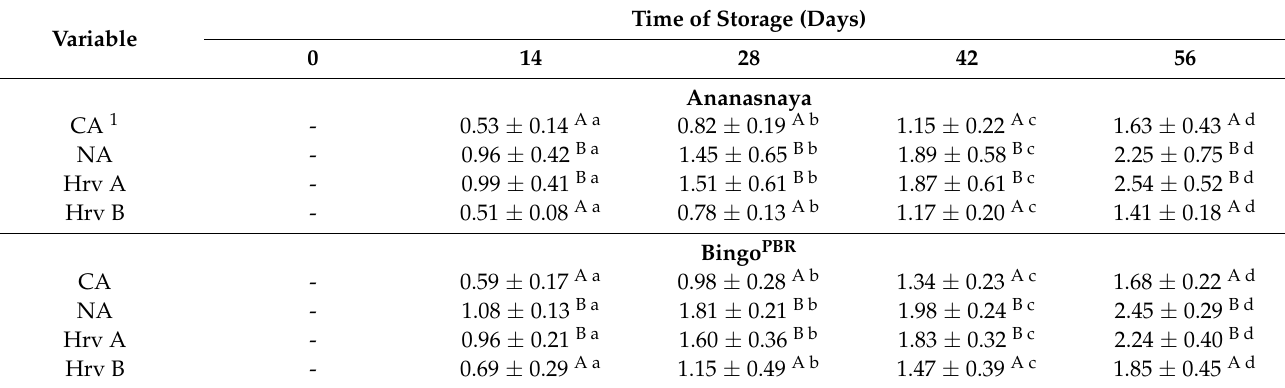
Table 4. Changes of fruit mass loss [%] measured in ‘Ananasnaya’ and ‘Bingo’ PBR minikiwi friuit in postharvest